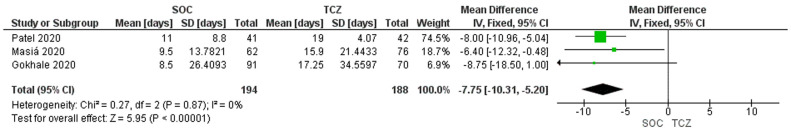
A forest plot length of stay baseline criteria for administration of tocilizumab CRP < 100 mg/L.SOC, standard of care; TCZ, tocilizumab; CRP, C-reactive protein; SD, standard deviation; CI, confidence intervals.